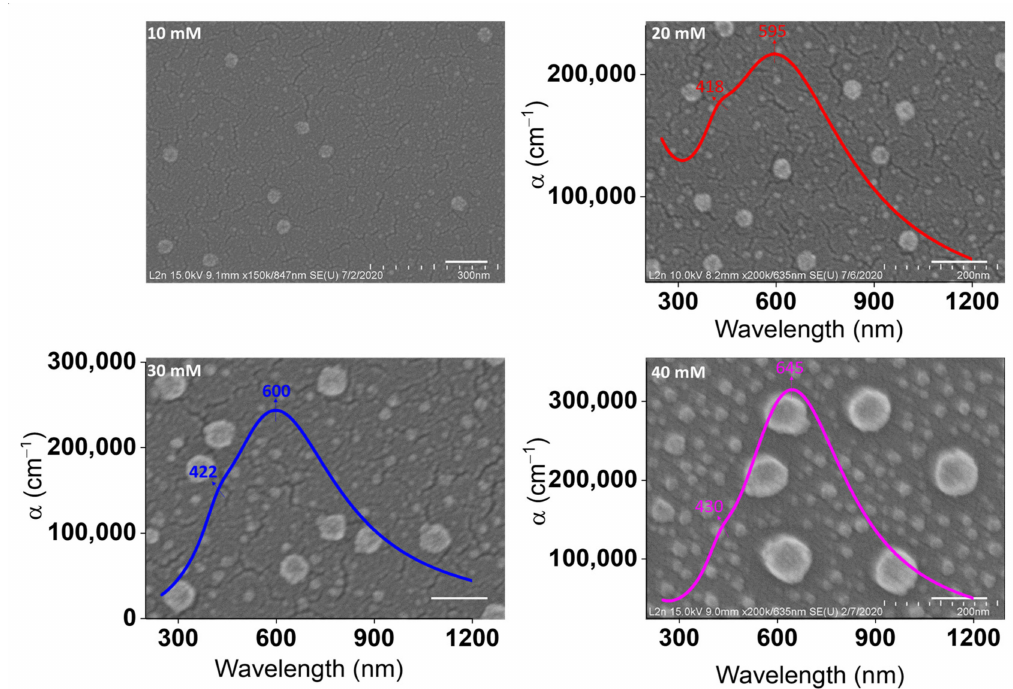
Figure 6. SEM images of Ag samples obtained by varying the concentration of Ag precursor. The scale bar is 100 nm. The insets show the absorption coefficient ( α ) of AgNPs/PMMA pre-synthesized substrates at each concentration.